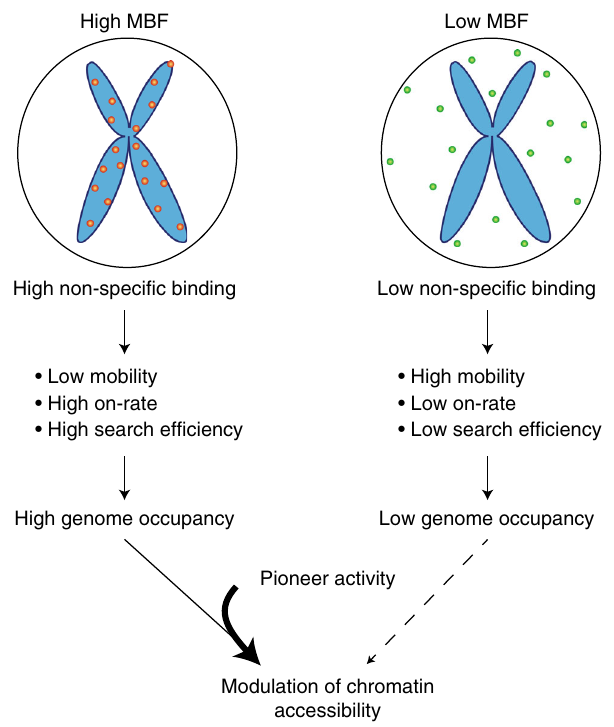
Fig. 6 Mitotic chromosome binding predicts TF properties in interphase We propose that the MBF allows to predict TF non-speci fi c DNA binding, which regulates TF mobility, on-rate and search ef fi ciency, thus in fl uencing genome occupancy. Modulation of chromatin accessibility at bound sites depends on genome-wide occupancy but even more so on pioneer